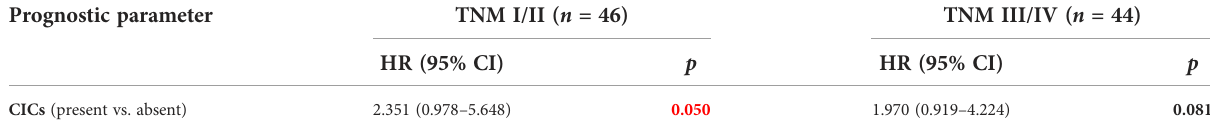
TABLE 4 Multivariate analysis of prognostic parameters for HCC strati fi ed by TNM. Prognostic parameter